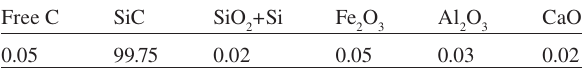
Table 3 Chemical composition of as-received SiC ( %